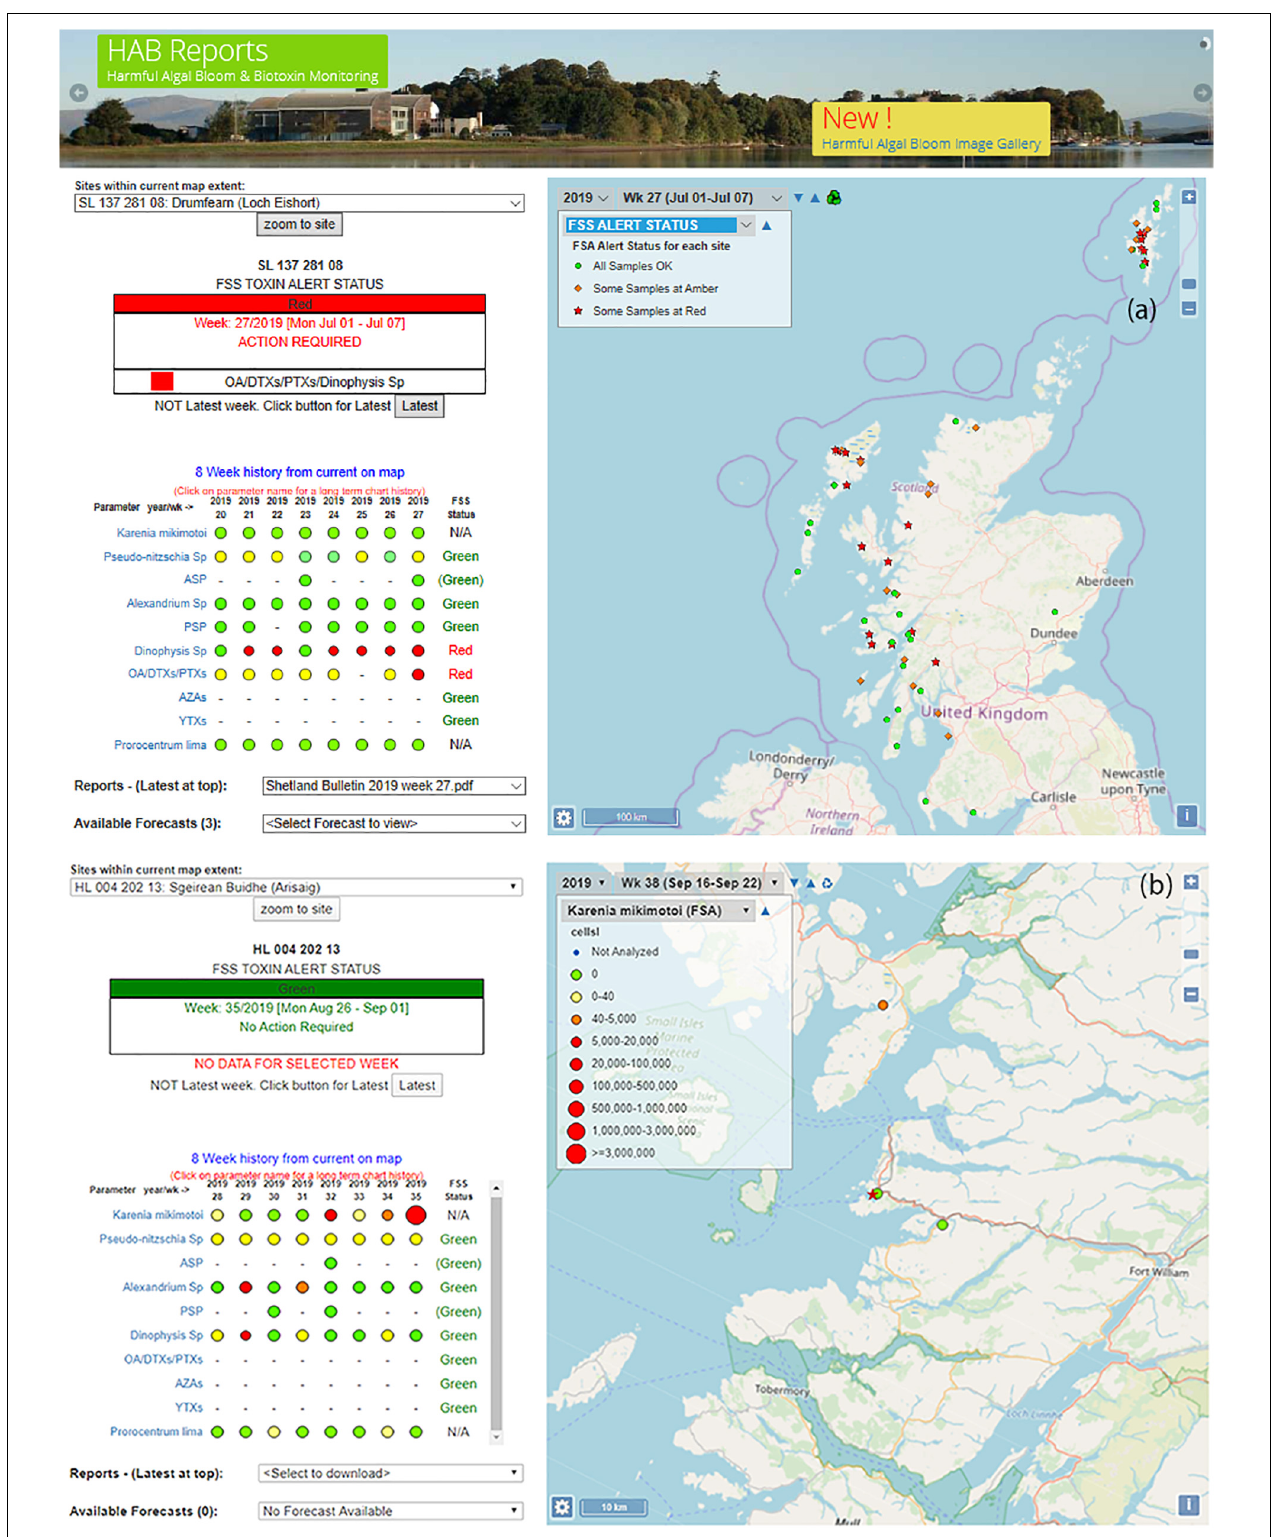
FIGURE 2 | Views (a) of front page of the of HABreports.org website for (a) the week of 1st of July 2019 at which time the selected site (Loch Eishort) had a red TTLG alert due to elevated concentration of Dinophysis and its associated toxins and (b) an enlarged view of the map component of the HABreports web site in which the abundance concentration of Karenia mikimotoi exceed 2.5 M cells · L − 1 for the week of 26th of August 2019 at the Arisaig site (star).